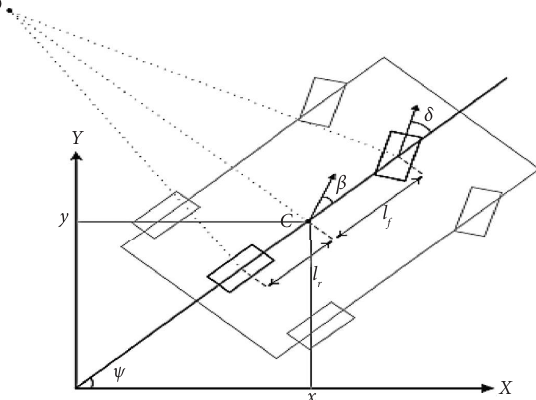
Figure 2: Kinematic bicycle